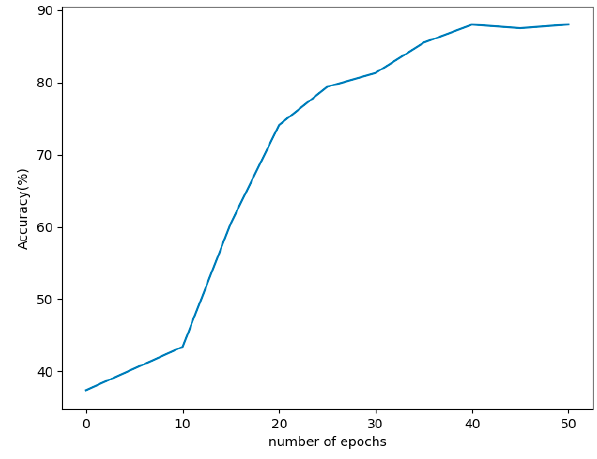
Figure 7. Accuracy graph for Intensified LSTM.